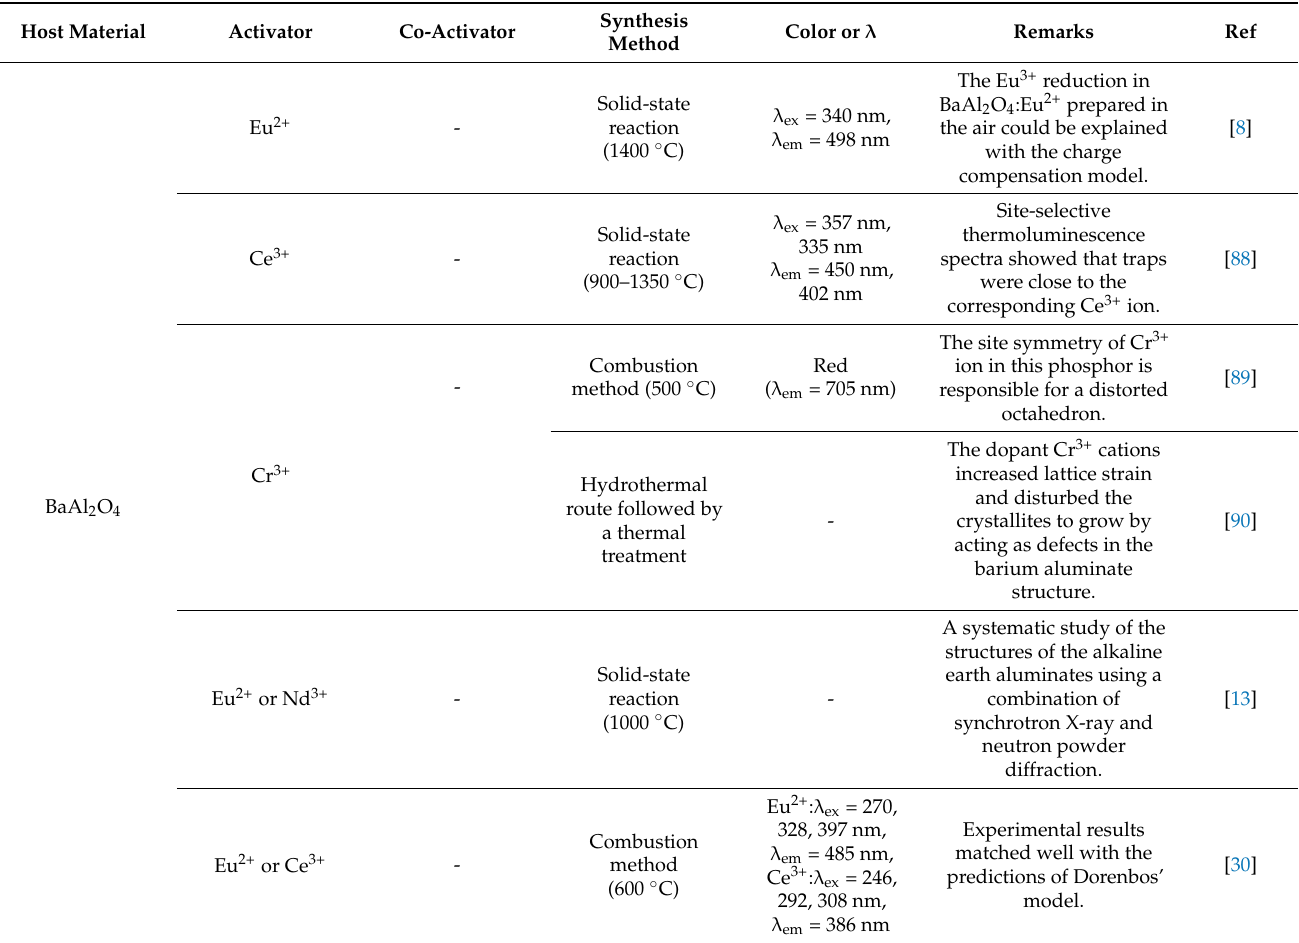
Table 3. Comparison of reported studies for the synthesis of lanthanide-doped barium aluminate phosphors. Host Material